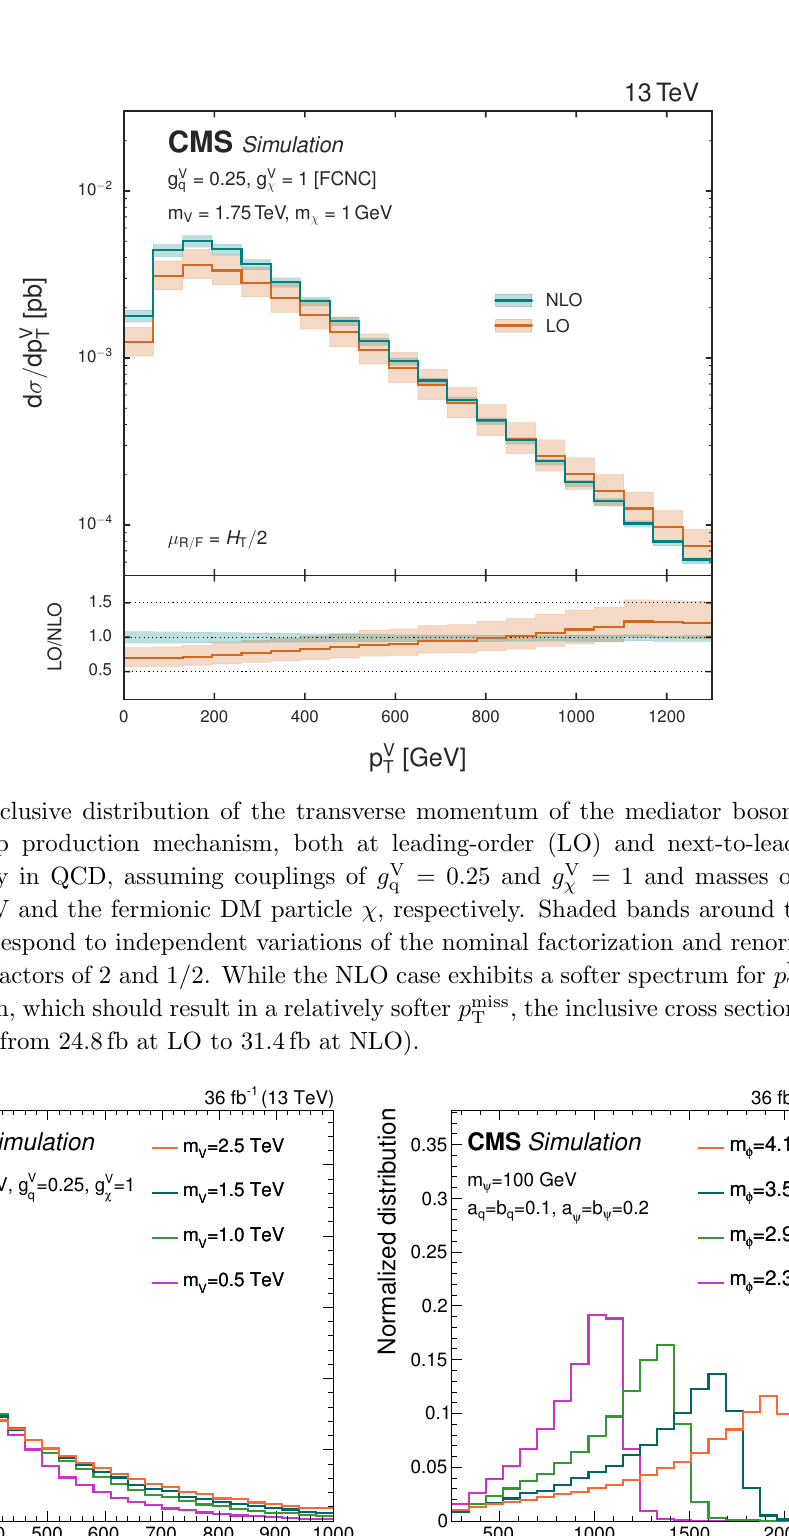
Figure 15 . Distribution of p miss in monotop signal models. On the left is shown the FCNC model T for various values of m V ; on the right is the scalar resonance model for various values of m (cid:30) .